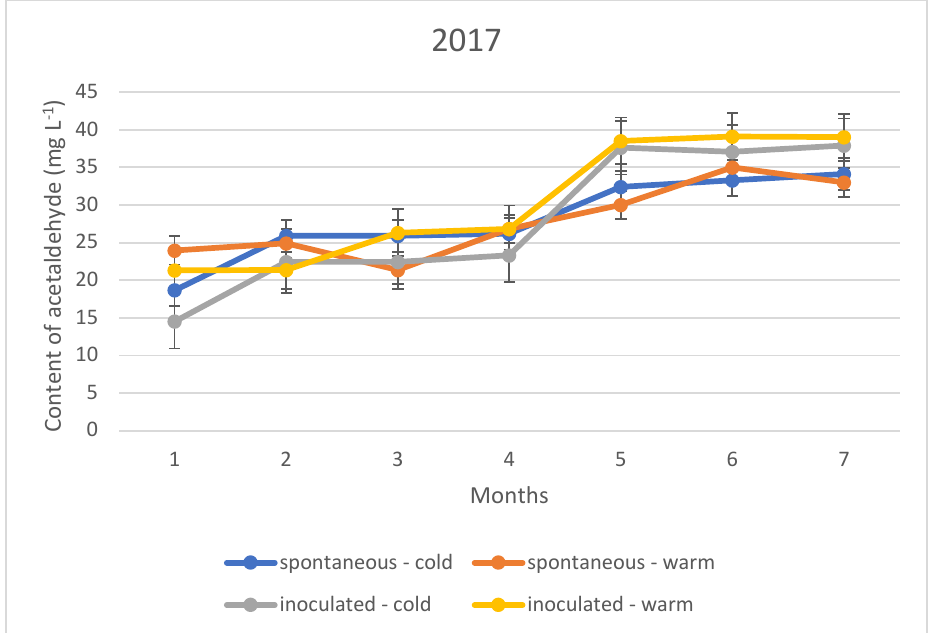
Figure 4. Acetaldehyde content of the wines tested during storage in 2017.